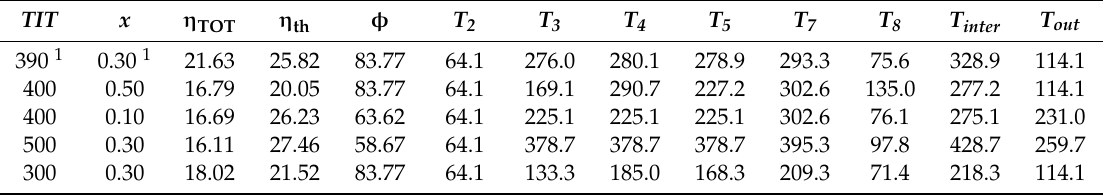
Table 4. Performance metrics and cycle parameters at the optimum and four sub-optimum points for the partial heating cycle. All temperatures are in °C.